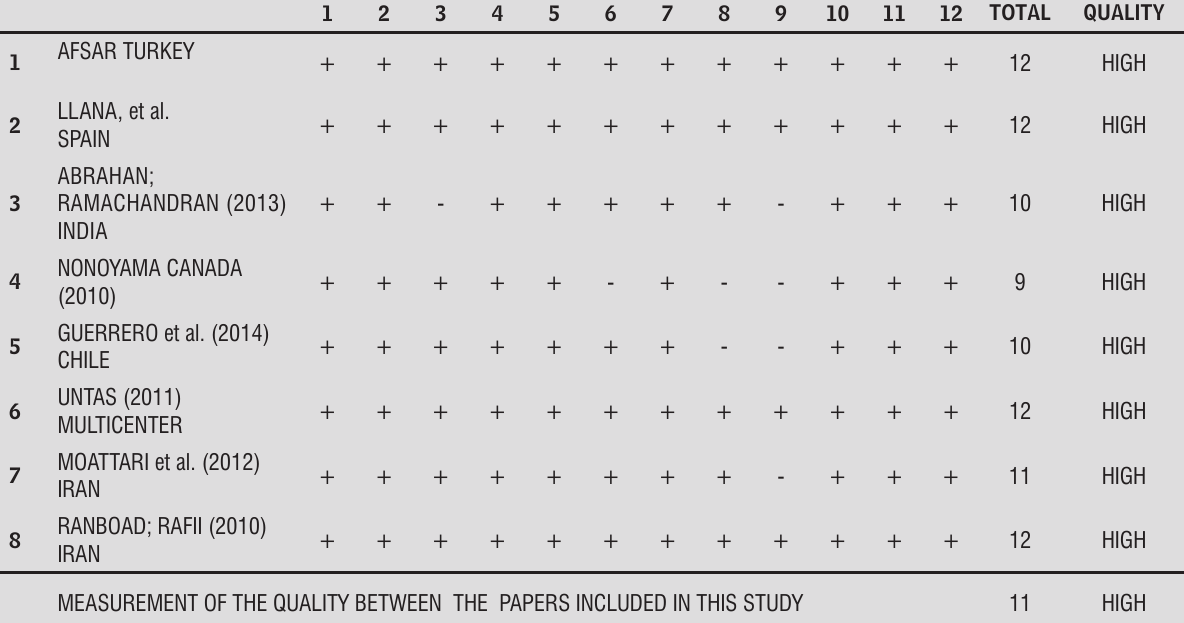
Table 1 - Exhibit of the methodological quality of the papers in the sample, Curitiba, Brazil,